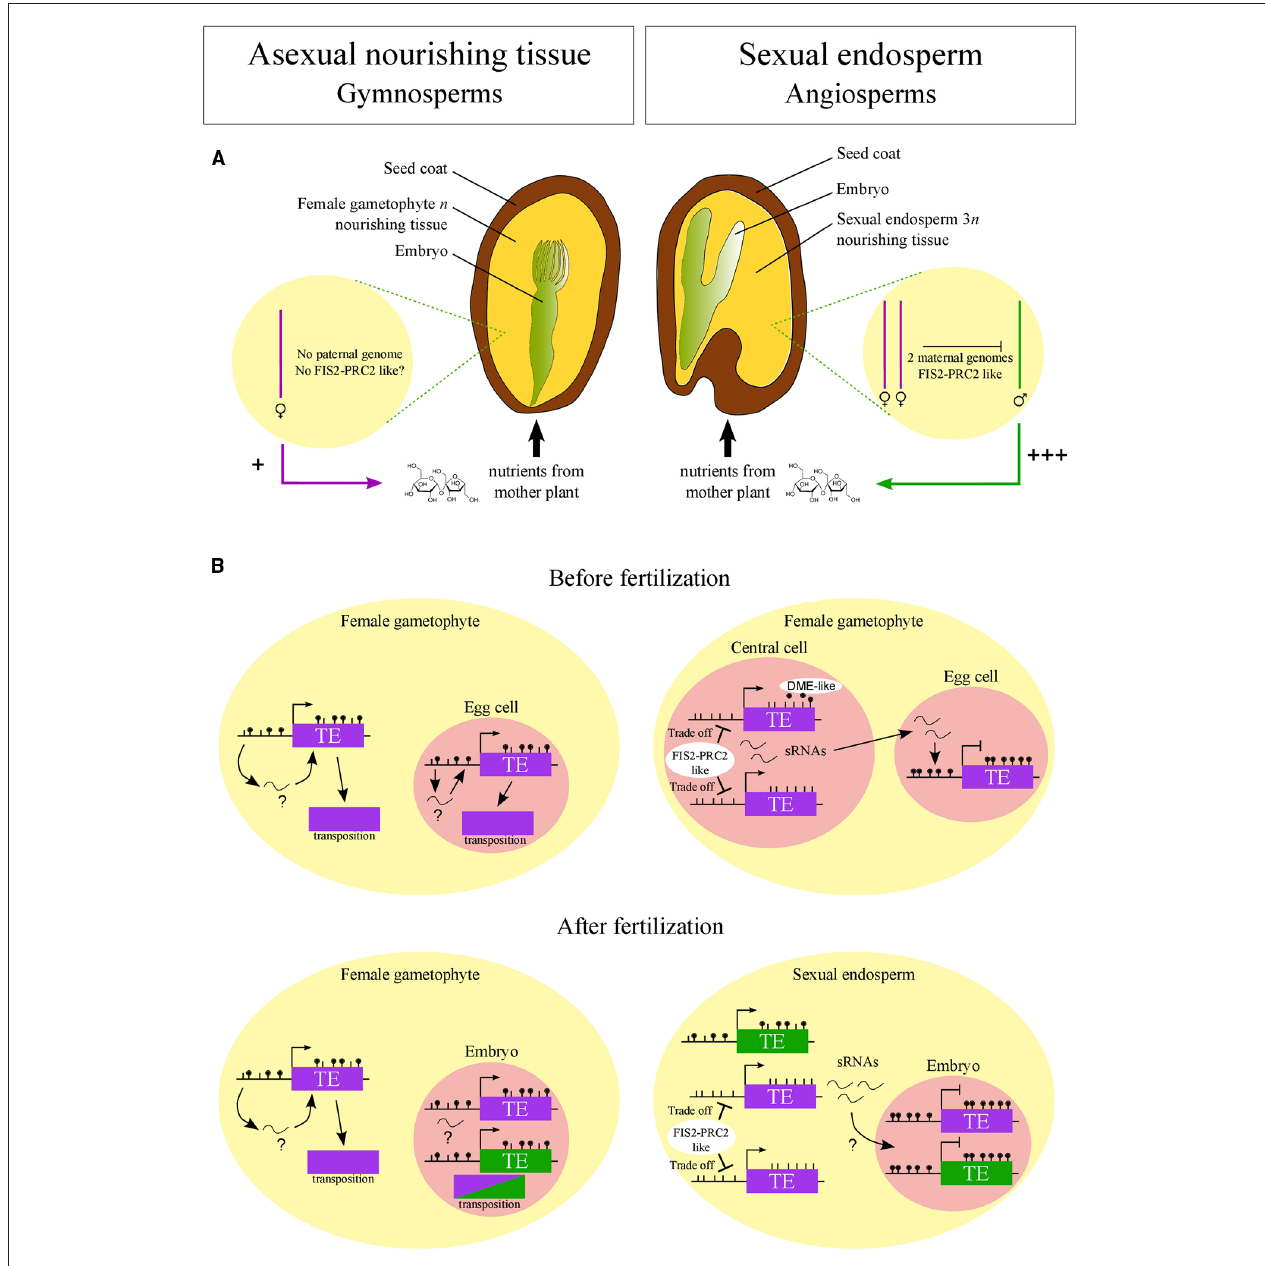
DME-like activity and small RNA (sRNA) production in central cell and endosperm. FIS2-PRC2 acts on hypomethylated regions, limiting the deleterious activity of transposable elements (TE). This tradeoff between TE silencing and activity allows the production of sRNAs traveling to the egg cell and embryo, reinforcing TE silencing. Such a demethylation process may not have emerged in gymnosperms, leading to a limited silencing of TEs and explaining the genome expansion in this taxon. Purple and green colors symbolize maternal and paternal genomes, respectively.